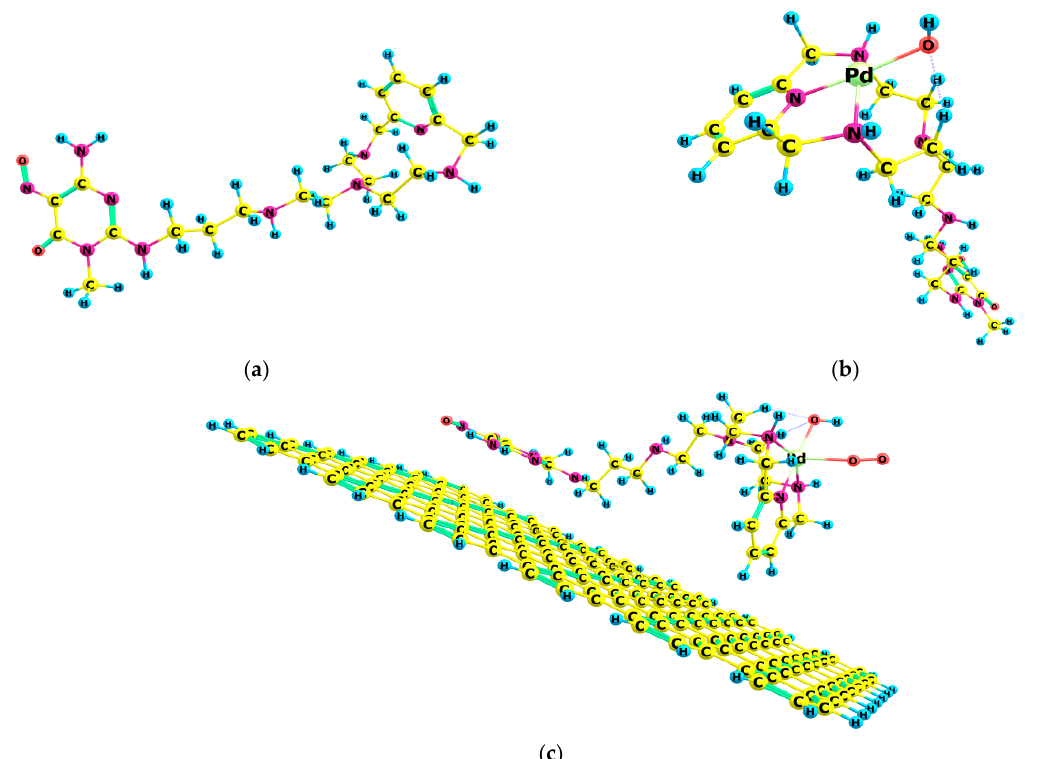
Figure 2. Molecular structures for the ORR catalyst: ( a ) HL2; ( b ) HL2-Pd(II)-OH − complex; ( c ) Cat2 final adduct C2D-HL2- Pd(II)-OH - with O 2 interaction.